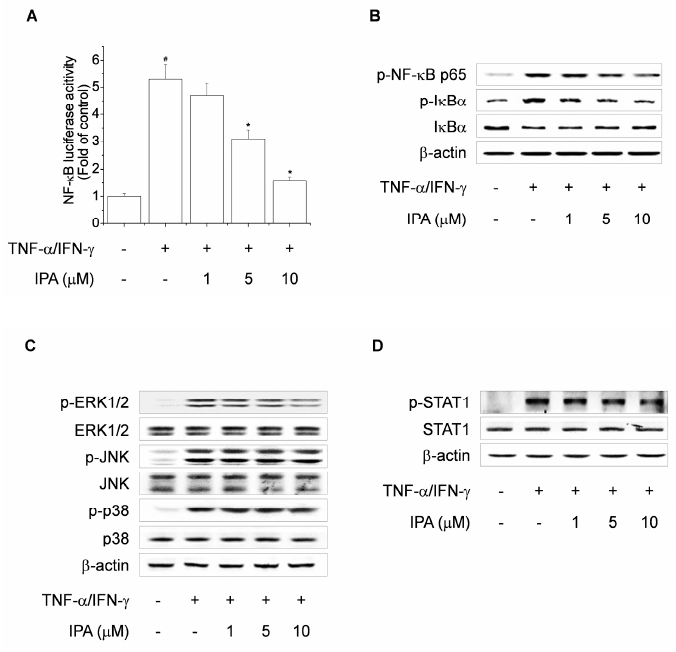
Figure 7. Inhibitory effects of IPA on activation of the NF- κ B, extracellular signal-regulated protein kinase (ERK1/2), and STAT1 signaling pathways in TNF- α /IFN- γ -stimulated HaCaT cells. ( A ) Cells were transiently transfected with reporter plasmids containing tandem elements of NF- κ B binding sites. After 5 h, the transfected cells were pretreated with IPA (1, 5, 10 µ M), and then treated with TNF- α /IFN- γ (each 10 ng/mL) for 24 h, and luciferase activity was evaluated. Results are means ± SD (n = 3). Cells were treated with TNF- α /IFN- γ for 30 min in the presence of IPA. Protein levels of ( B ) p-NF- κ B p65, p-I κ B α , I κ B α , and β -actin, ( C ) p-/t-MAPK and β -actin, and ( D ) p-/t-STAT1 and β -actin were assessed by Western blotting. # p < 0.01, versus the control group. * p < 0.01, versus the TNF- α /IFN- γ -treated group.